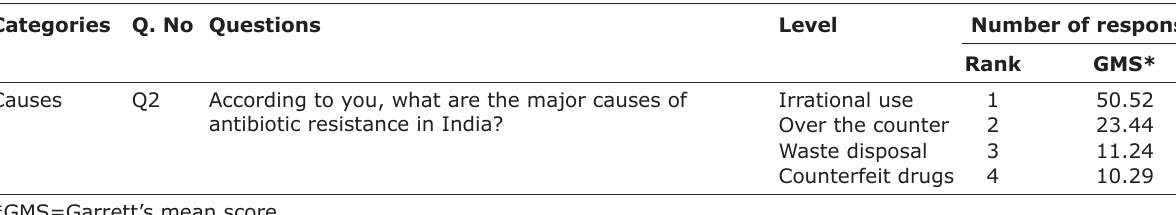
Table-2: Questions with the options and their corresponding ranks and GMS. Categories Q. No